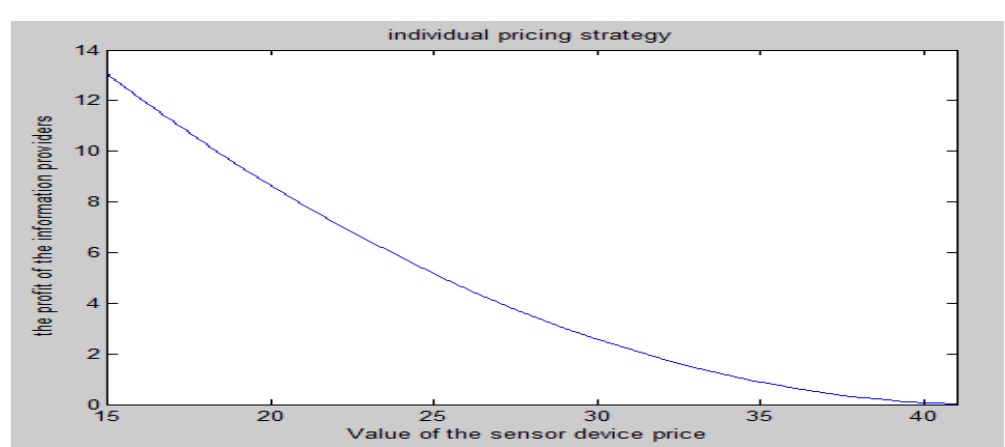
Figure 3. Profit  sc with individual pricing